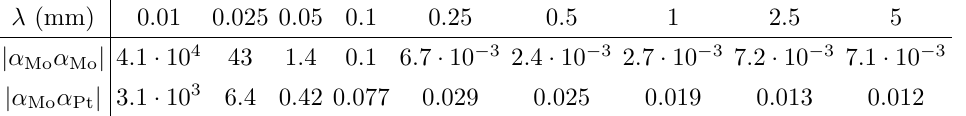
Table 7 . 95% C.L. constraints on the combinations | α Mo α Mo | [106] and | α Pt α Mo | [107] as a function of λ = 1 /m set by the Eöt-Wash experiment. a